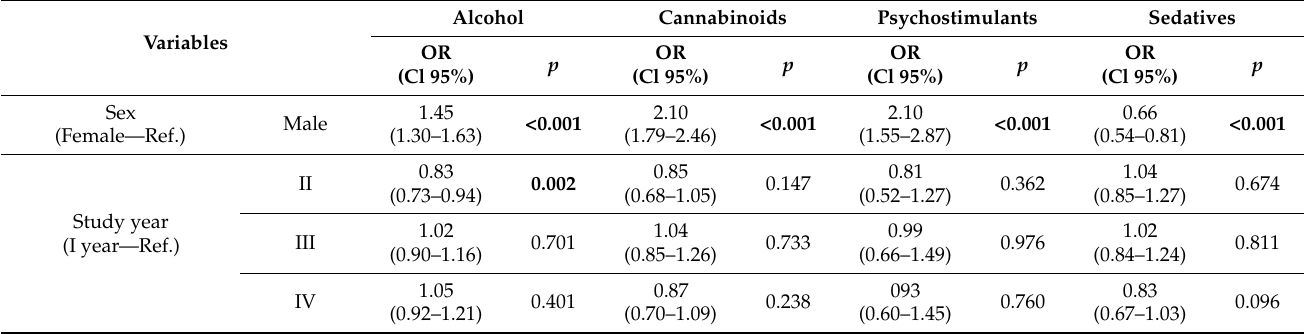
Table 5. Polynomial logistic regression analysis of sociodemographics and pandemic effects on the frequency of stimulants/alcohol and drug